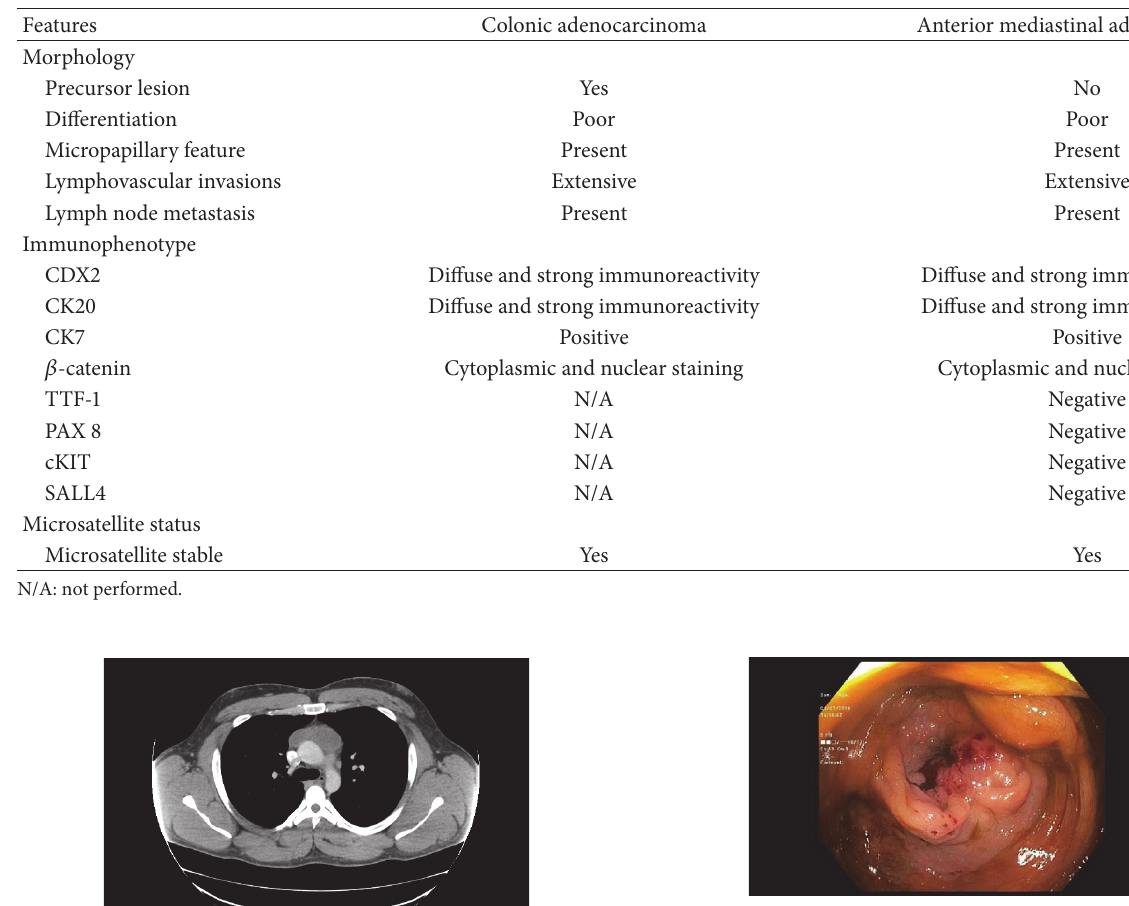
Table 1: Morphology and immunophenotype of the resected colonic and mediastinal adenocarcinomas.